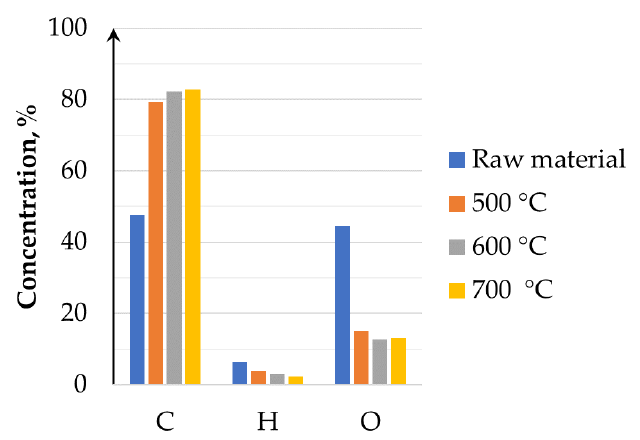
Figure 3. Ultimate analysis of chars in comparison to the raw material.